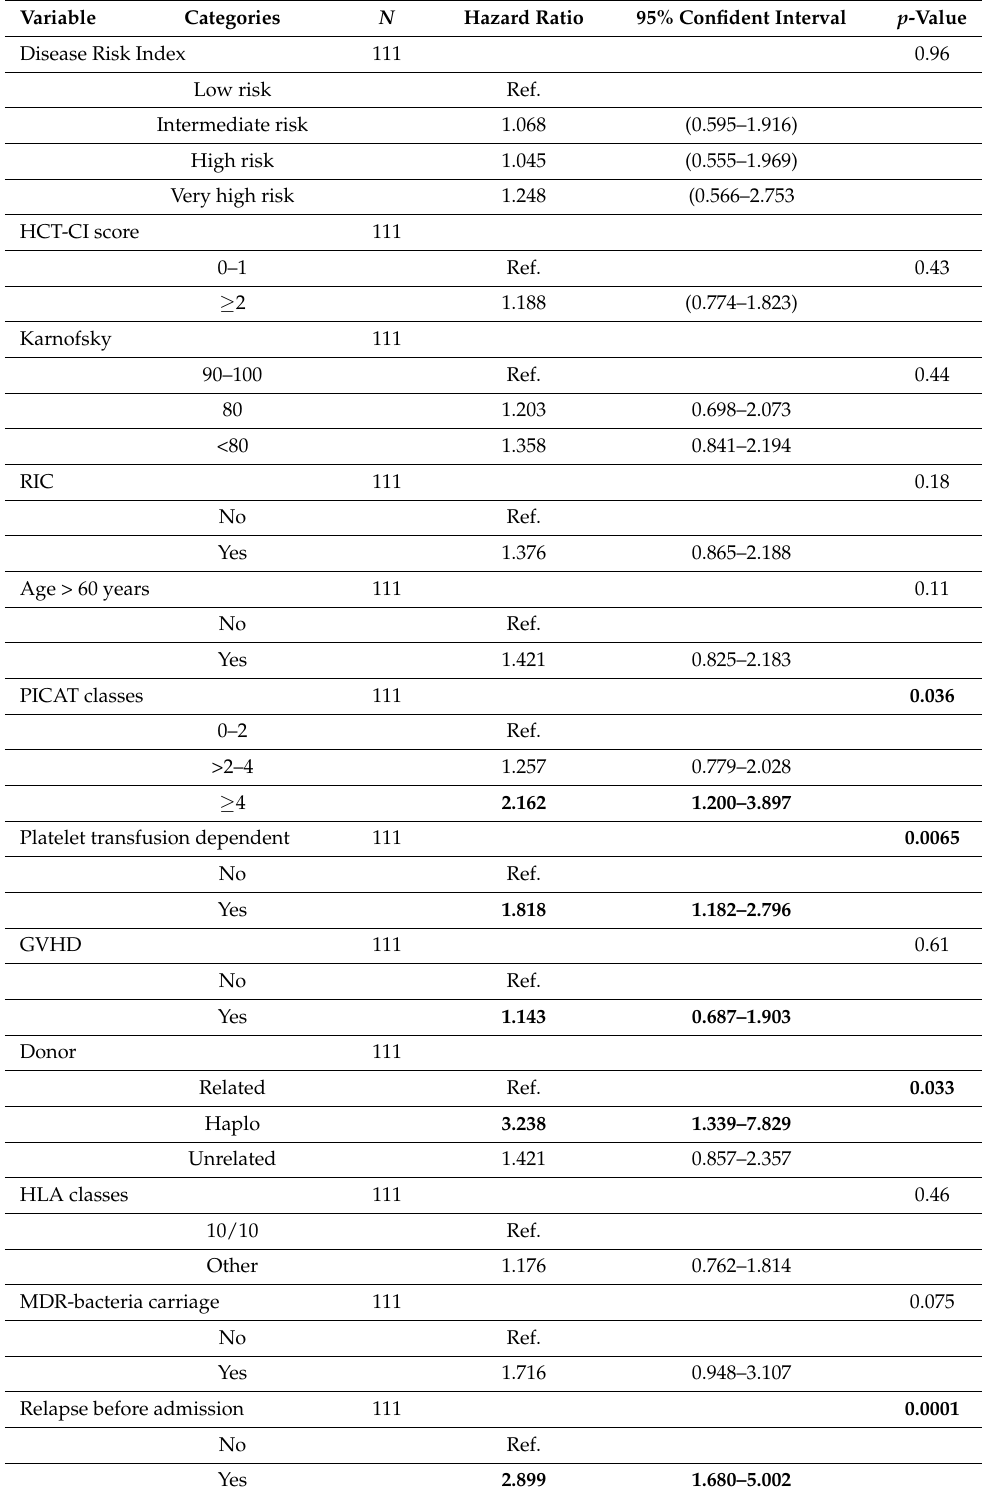
Table 3. Univariate Cox-regression analysis of overall